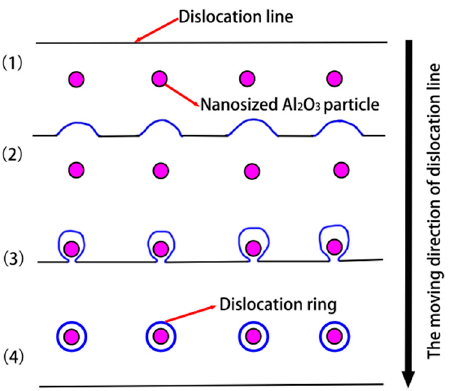
Figure 6. The schematic illustration of dislocation through particles mechanism.